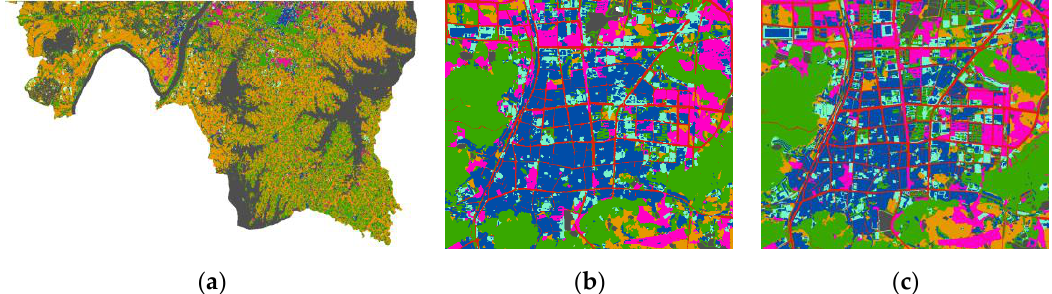
Figure 7. ( a ) The prediction results of land use classification using our FACNN network; ( b ) a zoomed area with 5535×4805 pixels; ( c ) the ground truth of the zoomed area.